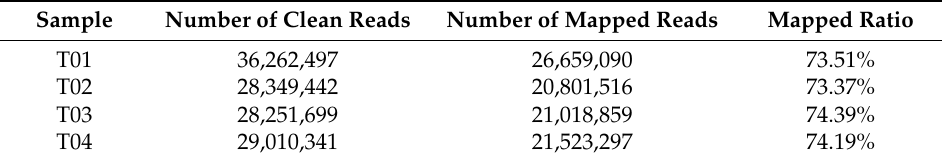
Table 3. Comparison of sequencing data and assembly results.